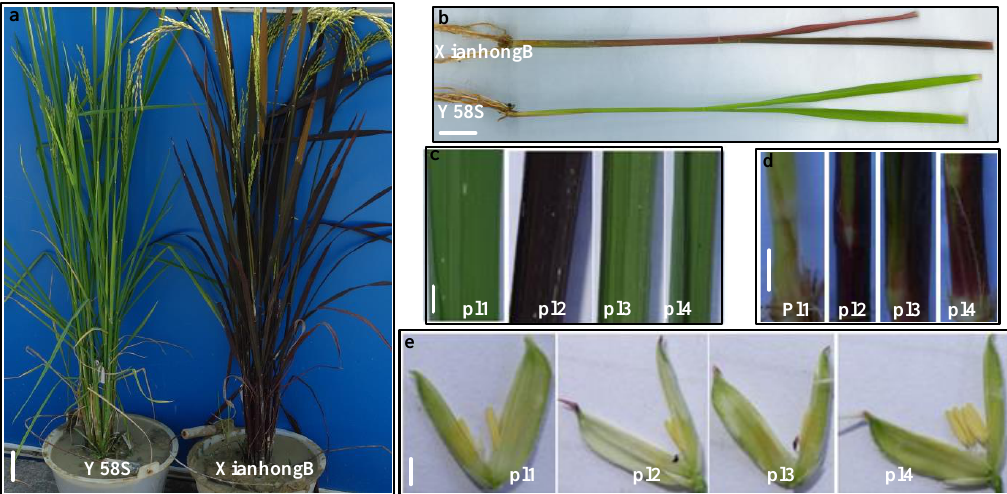
Figure 2. Phenotypic characteristics of purple leaf for different tissues and growth stages of rice. ( a ) heading stage, ( b ) seedling stage, ( c ) leaf, ( d ) leaf sheath, and ( e ) flower organ. The bar sizes are ( a ) 5 cm, ( b ), ( c ), ( d ), and ( e ) 1 cm.